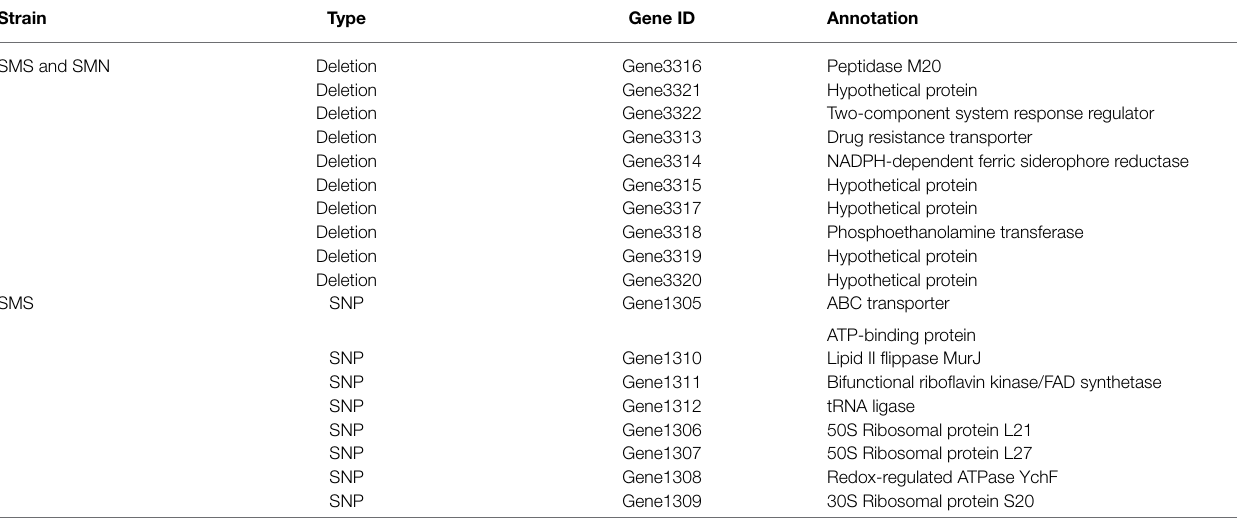
TABLE 3 | Summary of all indels and single-nucleotide polymorphisms (SNPs) located in the CDS of SMS and SMN.